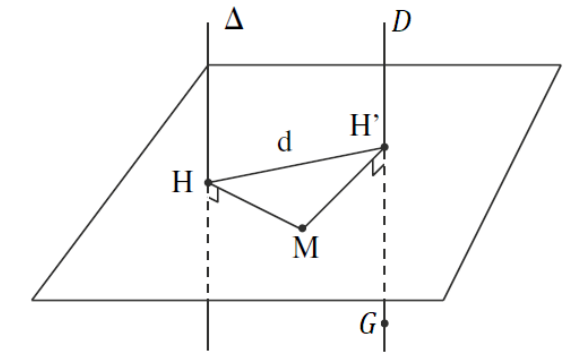
Figure 4. Huygens’s theorem (adapted from